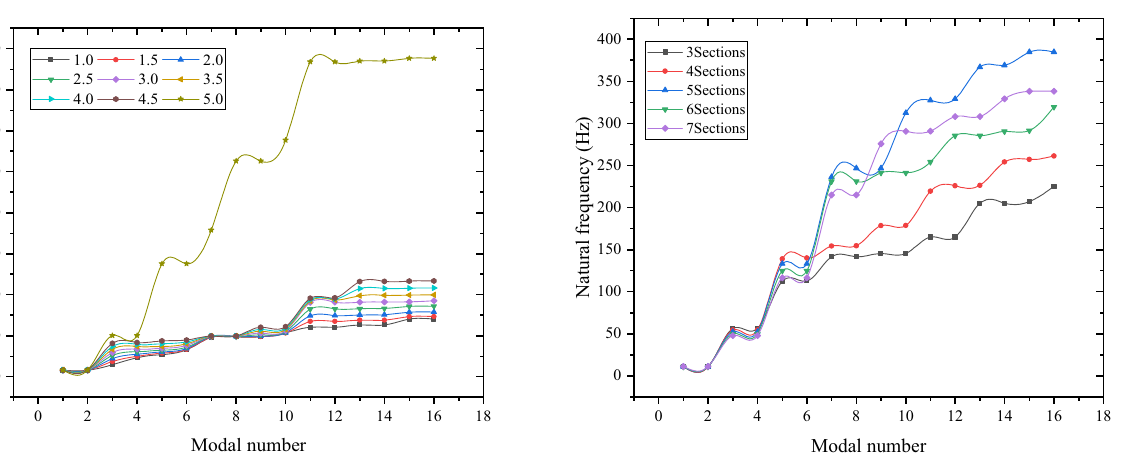
Figure 15 Effect of number of sections on vibration